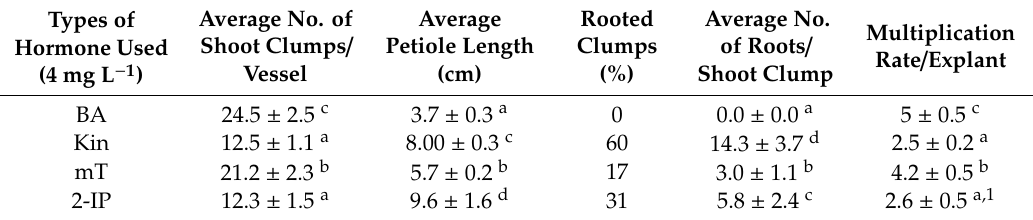
Table 1. The influence of cytokinins upon in vitro multiplication in Rheum rhabarbarum L. after eight weeks.